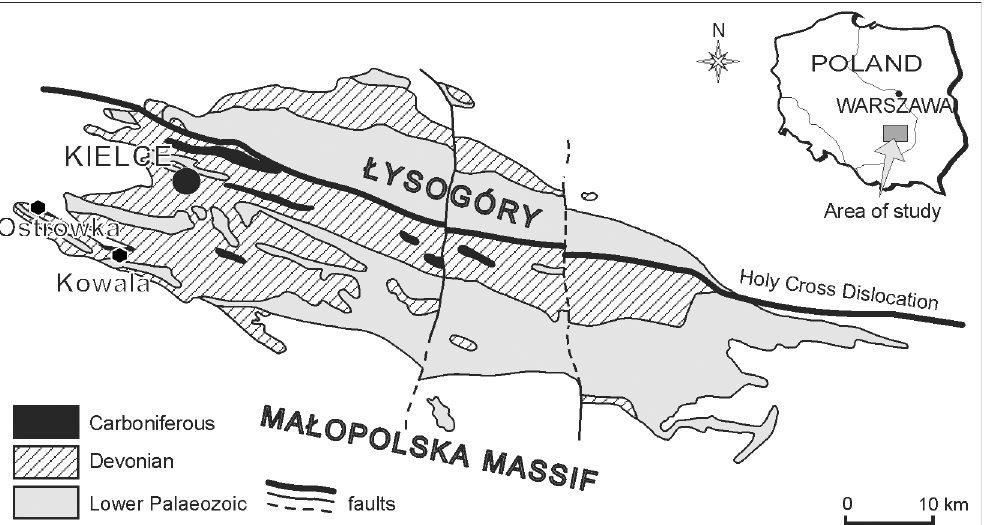
Fig 1. Simplified geological map of the Holy Cross Mts. Based on [23], modified and taken from [9] with Kowala and Ostrówka sites marked. Reproduced from [9] with permission from Acta Geologica Polonica